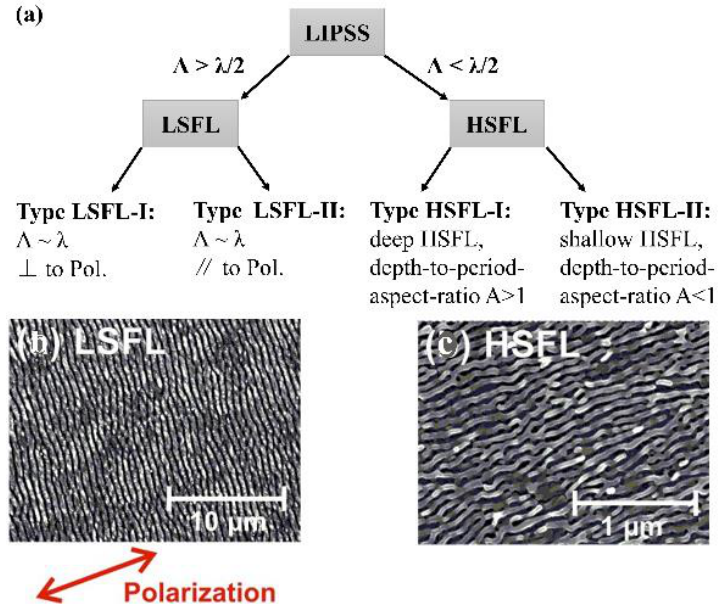
Figure 1. ( a ) General classification of fs-laser-induced periodic surface structures. SEM micrographs [37] of near wavelength LSFL-I ( b ) and sub-wavelength HSFL-II ( c ) on Ti6Al4V surfaces after irra- diation with fs-laser in the air (pulse duration τ = 30 fs, center wavelength λ = 790 nm, pulse repetition frequency 1 kHz). The double arrows in ( b ) mark the direction of laser beam polarization.